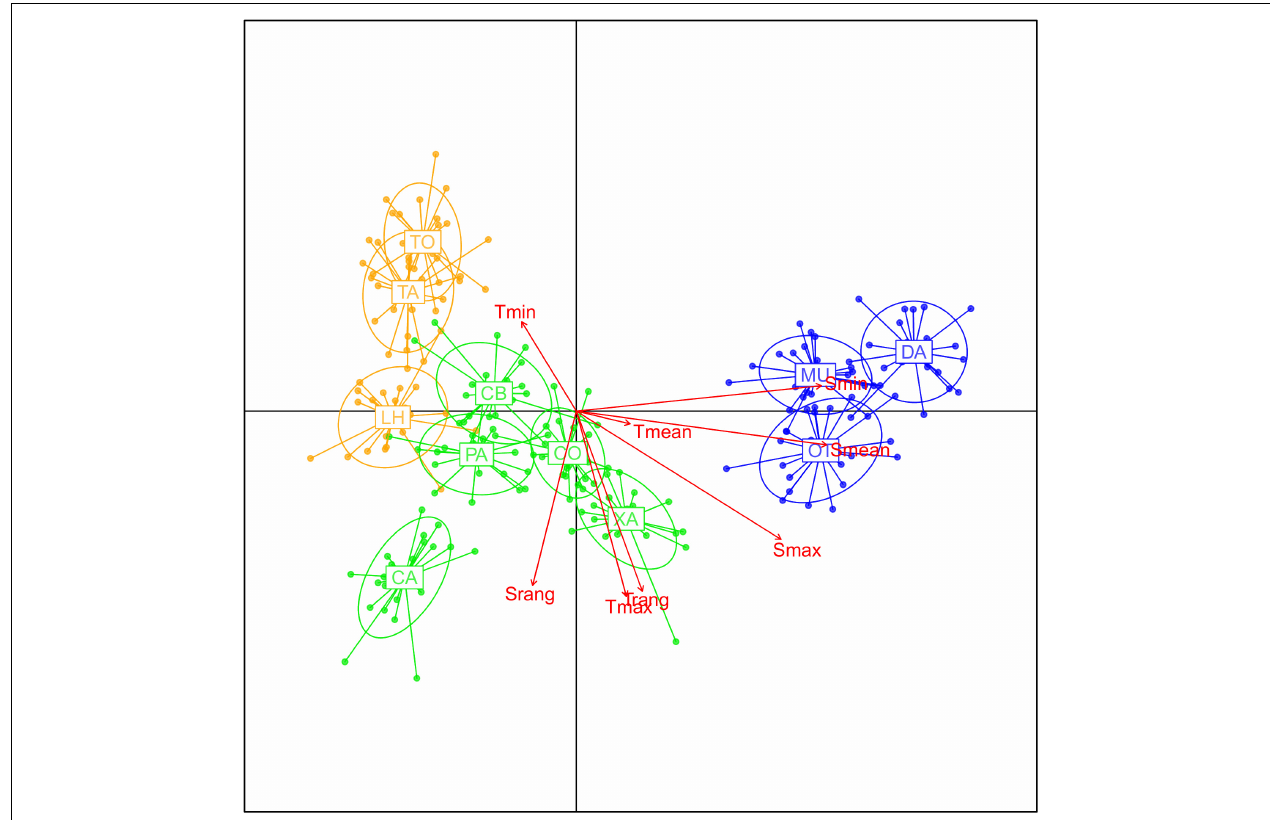
FIGURE 3 | Results of the DAPC using populations as prior groupings and retaining 160 PCs as indicated by the “xvalDapc” function. The fitted vectors of the environmental variables considered are superimposed.